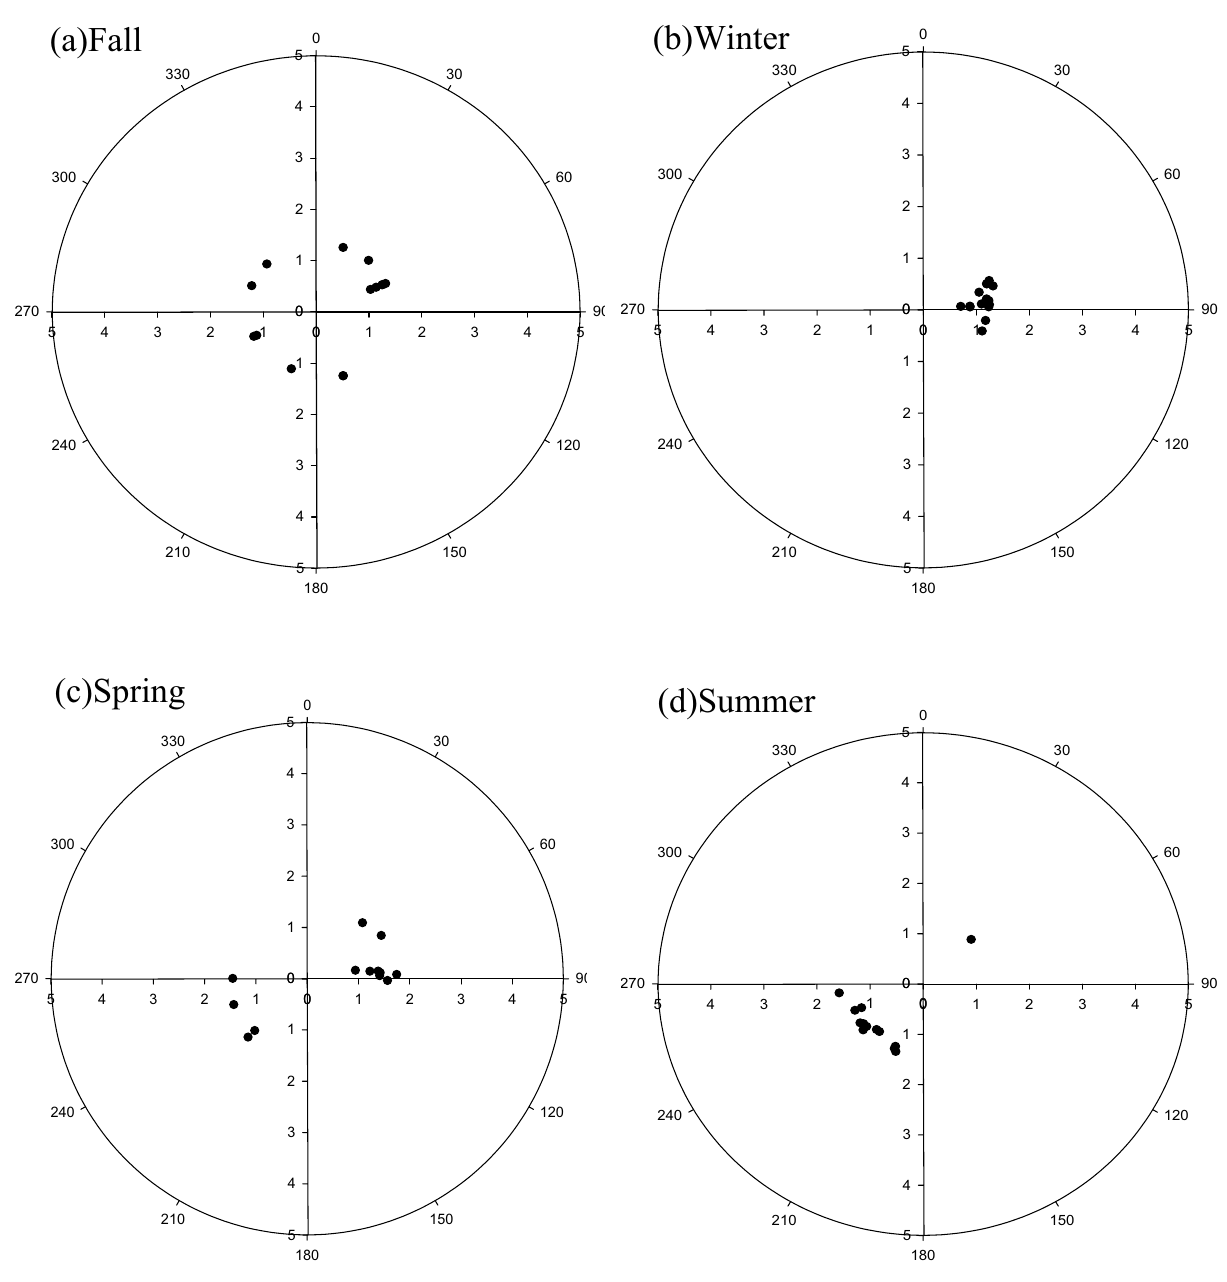
Figure 4. Pollution rose of GEM concentration at the Nansha